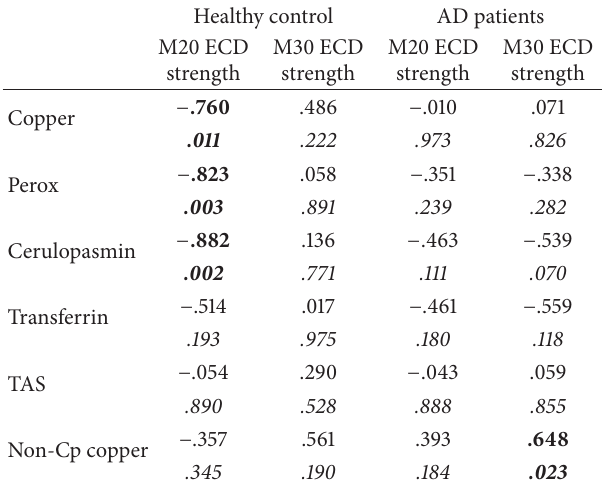
Table 3: Correlation between SM1 excitability and metal